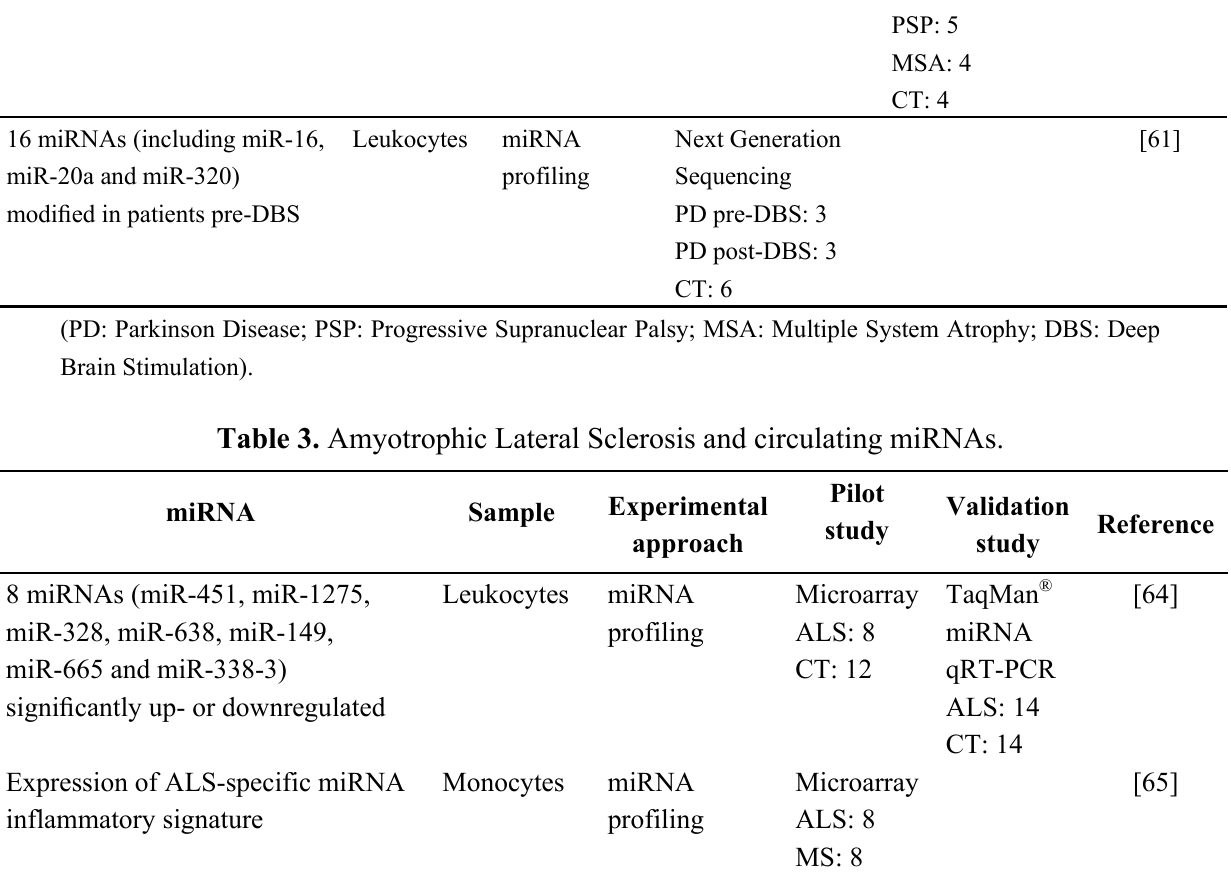
Validation study